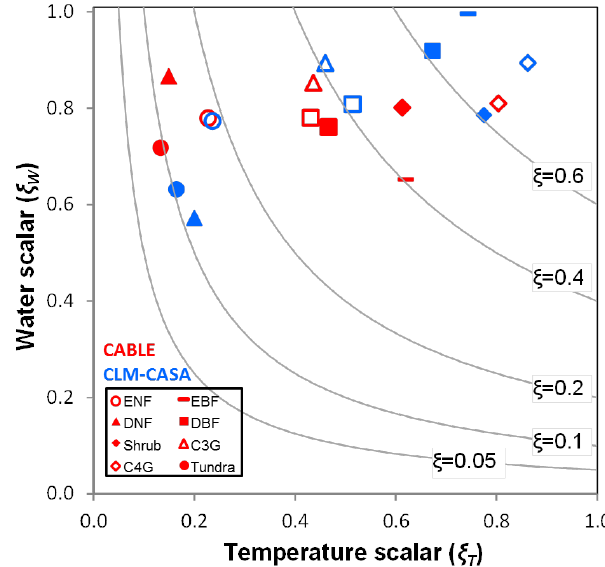
Figure 5. Determination of environmental scalars by the tempera- ture and water scalars (at global and biome level) between CABLE and CLM-CASA (cid:48) . Open squares show the global values. The con- tour lines show the constant value of environmental scalars. Abbre- viations of biomes are given in Fig.